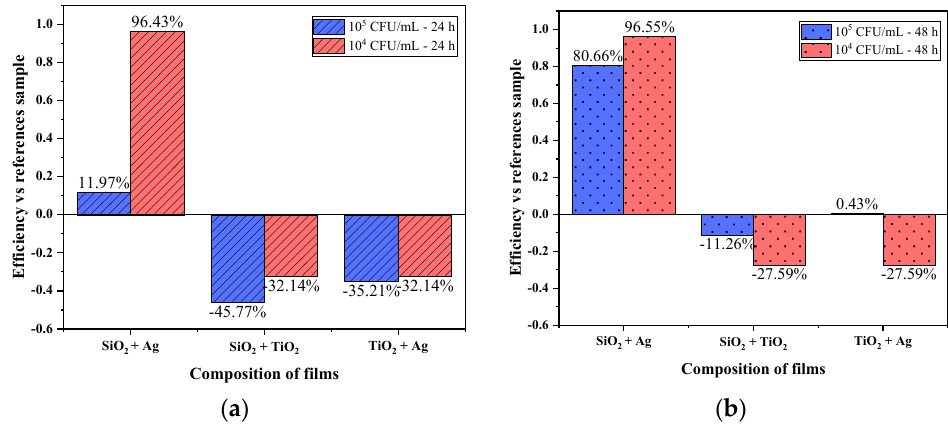
Figure 10. Antimicrobial efficiency of SiO 2 + Ag, SiO 2 + TiO 2 , TiO 2 + Ag films against Escherichia coli at two concentrations of 10 5 and 10 4 CFU/mL and two incubation times of 24 ( a ) and 48 h ( b ).